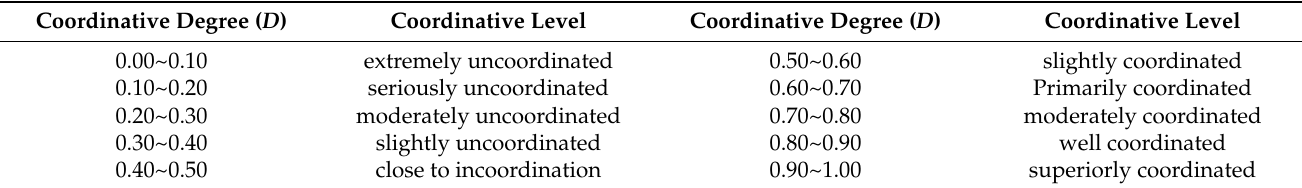
Table 3. Criteria for the coupling and coordinative degree between the agriculture industry and the tourism industry.